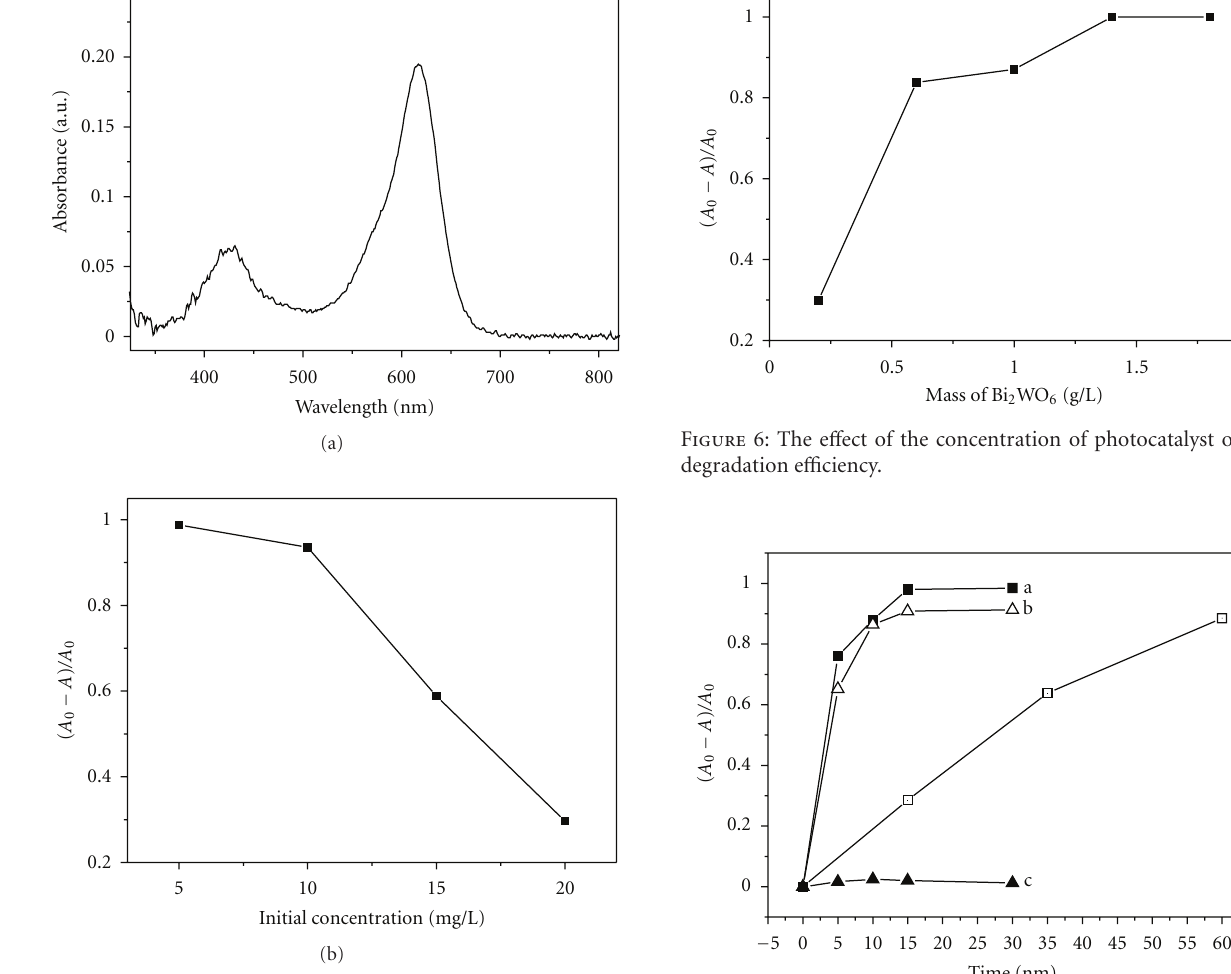
Figure 4: (a) The absorption spectrum of malachite green. (b) The e ff ect of the initial concentration of malachite green on the degradation e ffi ciency.